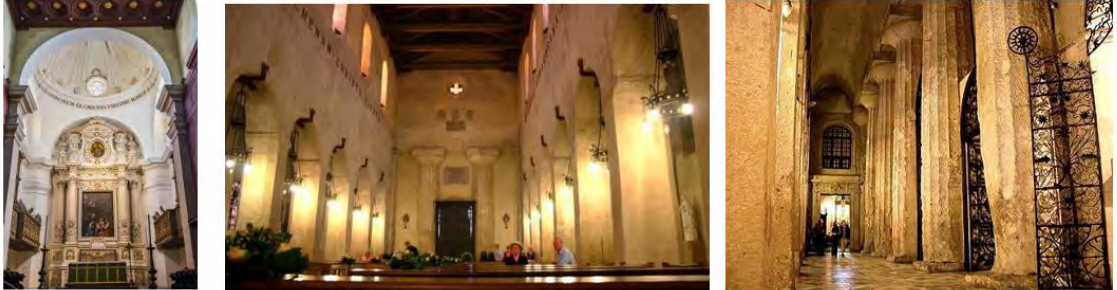
Figure 1. At the Duomo at Syracuse, three unmistakable styles—Greek Doric, Romanesque, and florid—are obvious from different vantages of the house of prayer. The design forbear of the house of prayer feels durable in spite of the dissimilar styles